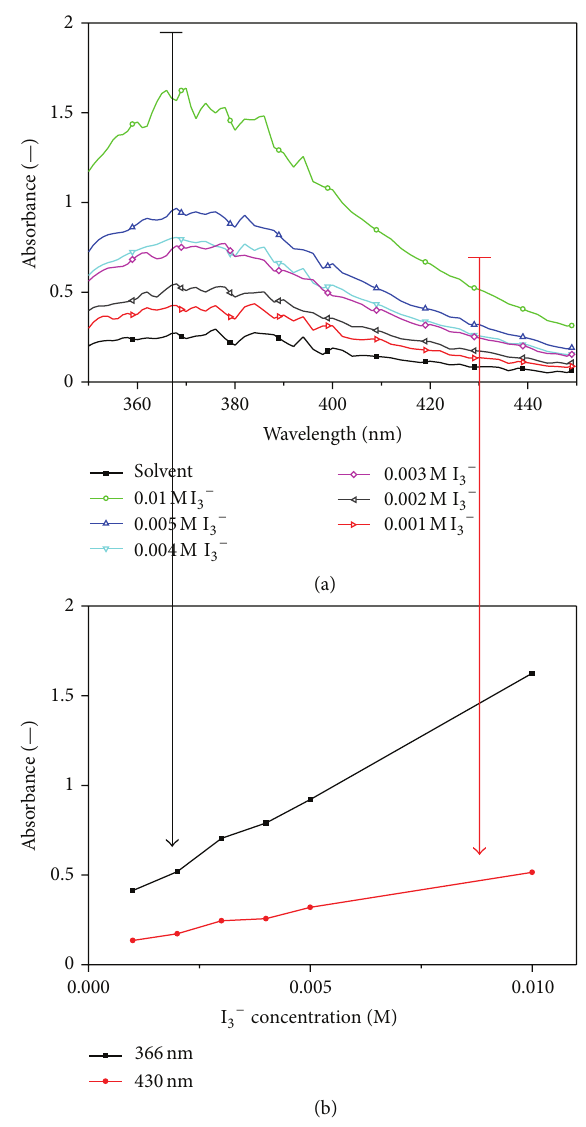
Figure 3: (a) Absorbance spectra of I 3− in PMIM-I at various concentrations. 45 𝜇 m light path length, H 2 O as baseline. The absorbance peak of I 3 − is seen at 366 nm. (b) Linear dependence of I 3− concentration with absorbance at, respectively, 366nm and 430 nm. The linearity at 430 nm is important since the absorbance spectra for the test cells are saturated at 366nm. Therefore, the decrease in absorbance at 430 nm for the test cells is correlated with the loss of I 3−